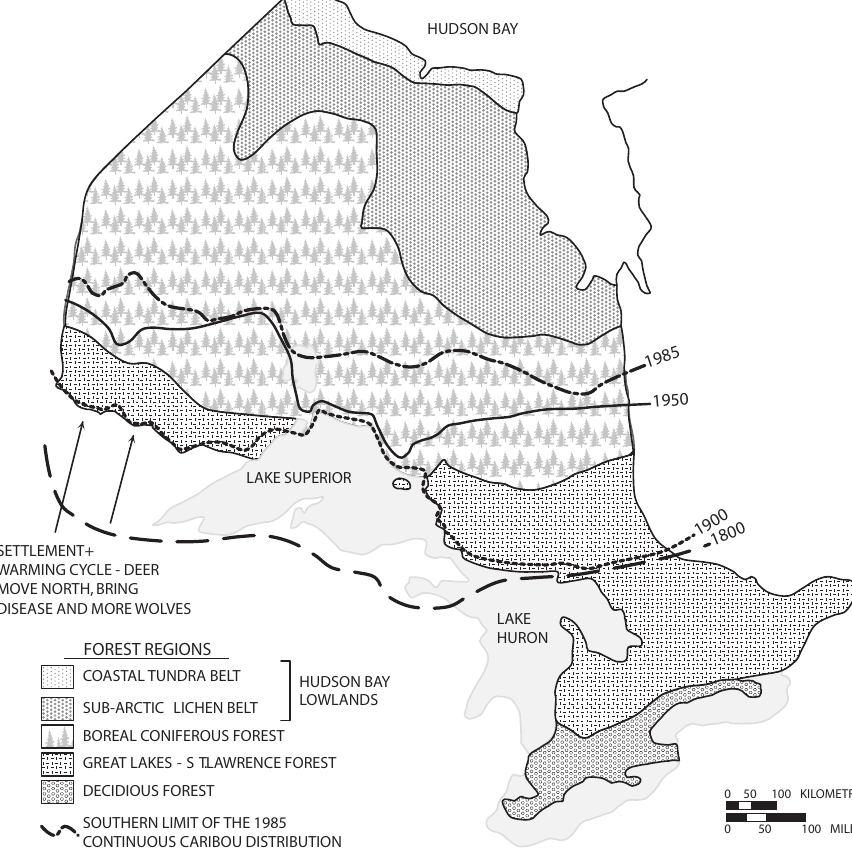
Fig. 2. The line of continuous distribution has moved northward since the end of the Little Ice Age as moose and deer moved north increasing the mortality of caribou through predation and disease. Hunting also contributed to the decline of